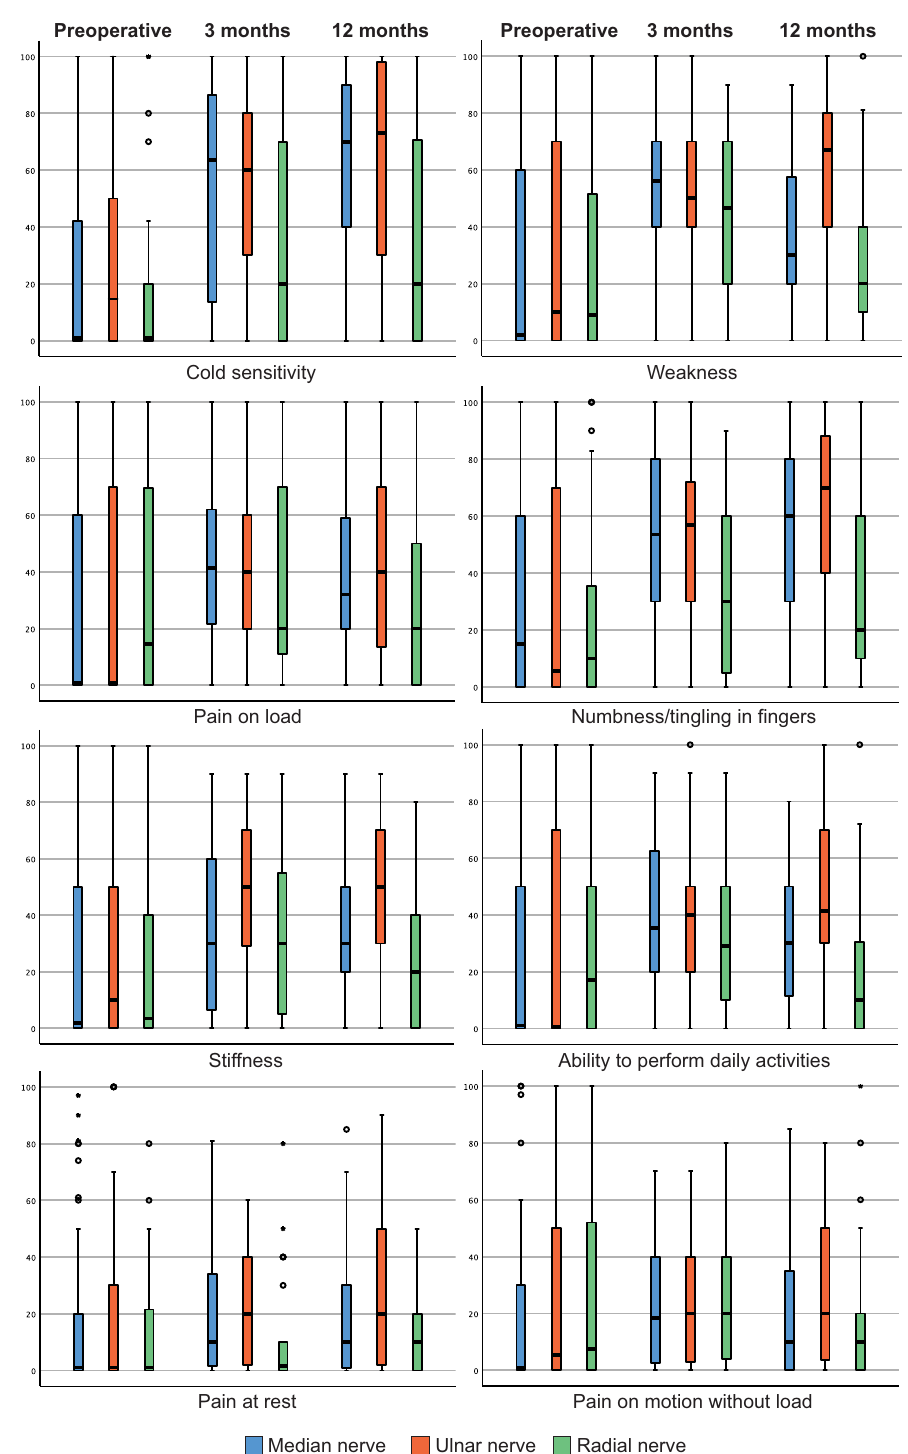
Fig 2. Boxplot of HAKIR questionnaire (HQ-8) results over time for patients with a median, an ulnar or a radial nerve injury. All eight questions presented individually, graded from 0–100 on a Likert scale, with a higher score representing more severe